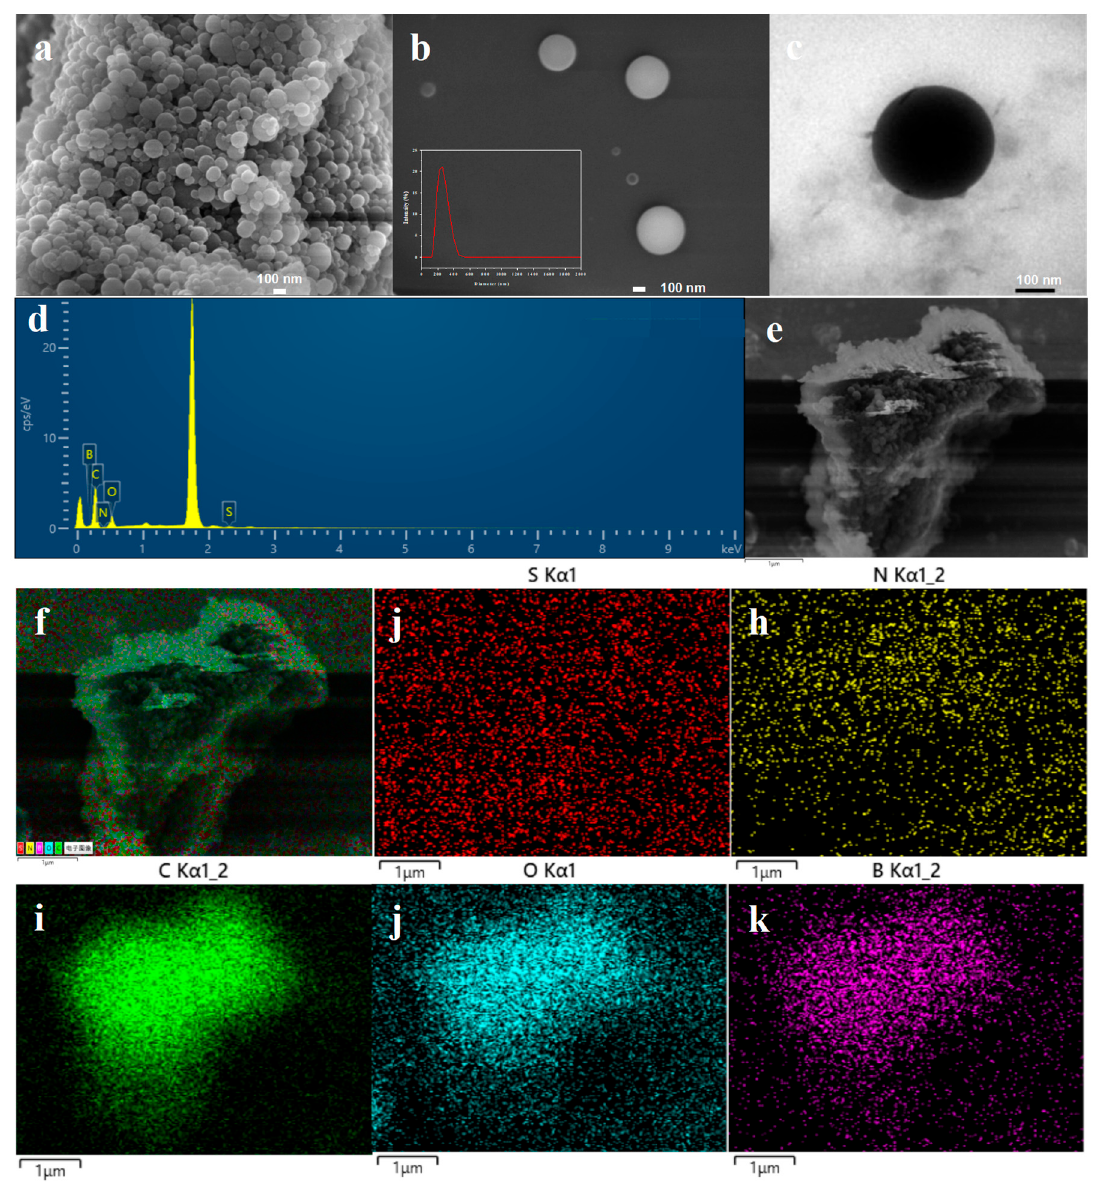
Figure 1. SEM ( a , b ), TEM ( c ), X-ray energy spectra ( d ) and elemental distribution ( e – k ) of poly(VPBA-AAm)-CD. The inset in b is the particle size distribution of poly(VPBA-AAm)-CD hybrid microgel. The thermal stabilities of poly(VPBA-AAm)-CD and poly(VPBA-AAm) were investi- gated by thermogravimetric analysis (TGA). As demonstrated in Figure 2b, weight losses of 9.59% and 11.7% for poly(VPBA-AAm) microgel and poly(VPBA-AAm)-CD hybrid mi- crogel, respectively, were observed in the temperature ranges of 25–320 ◦ C and 25–380 ◦ C, and this weight loss was mainly attributed to the loss of the physically adsorbed water molecules [45]. The skeleton decomposition of poly(VPBA-AAm)-CD was from 380 to 635 ◦ C, and the weight loss at this stage was 57.7%. While the skeleton decomposition of poly(VPBA-AAm) was from 320 to 606 ◦ C, the weight loss at this stage was 64.4%. After that, the weight of poly(VPBA-AAm)-CD and poly(VPBA-AAm) remained unchanged at 635 ◦ C and 606 ◦ C, respectively, and the residual weights were 30.56% and 25.97%, which were mainly boron